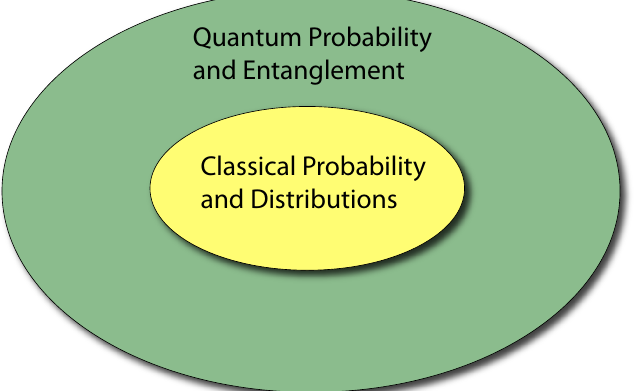
Figure 2. Quantum probability is an extension of classical probability. It is a mathematical tool which simplifies the description of vector data. The schoolbook notion of “probability” as being estimated by counting frequencies [2] or by making distributions refers to a classical procedure that does not capture the broader features of quantum probability originating in the Born